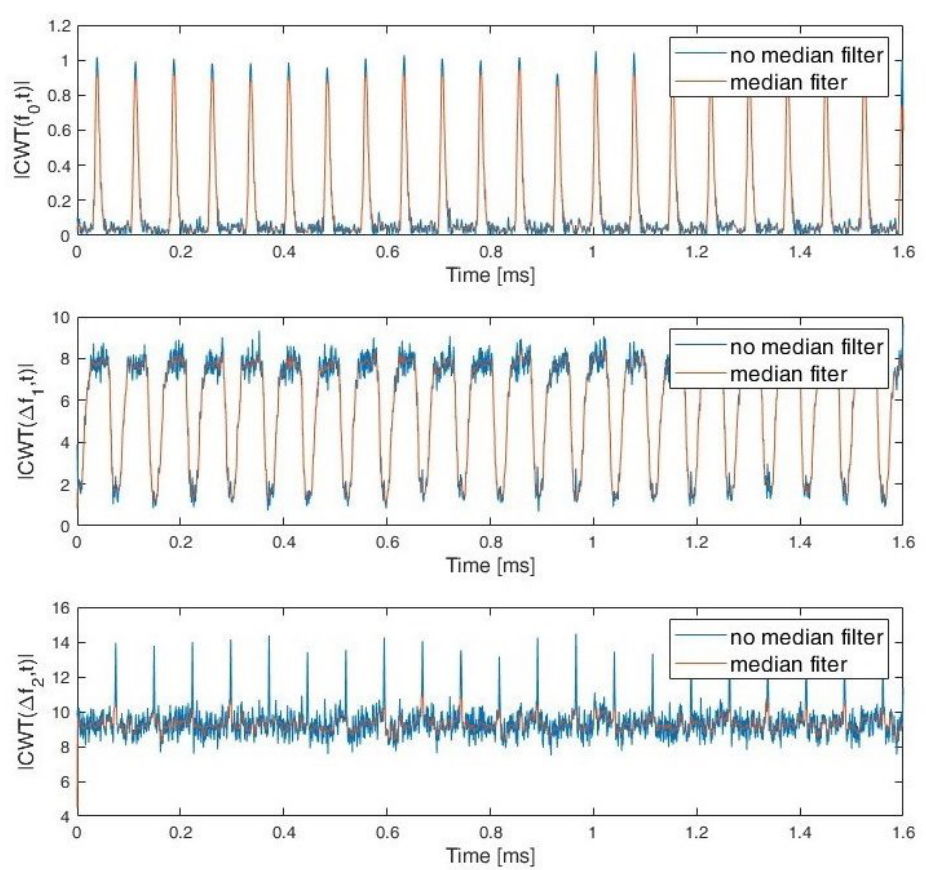
Figure 9. CWT frequency cut for f o ∼ = f c and sum of CWT coefficients in range ∆ f 1 and ∆ f 2 .